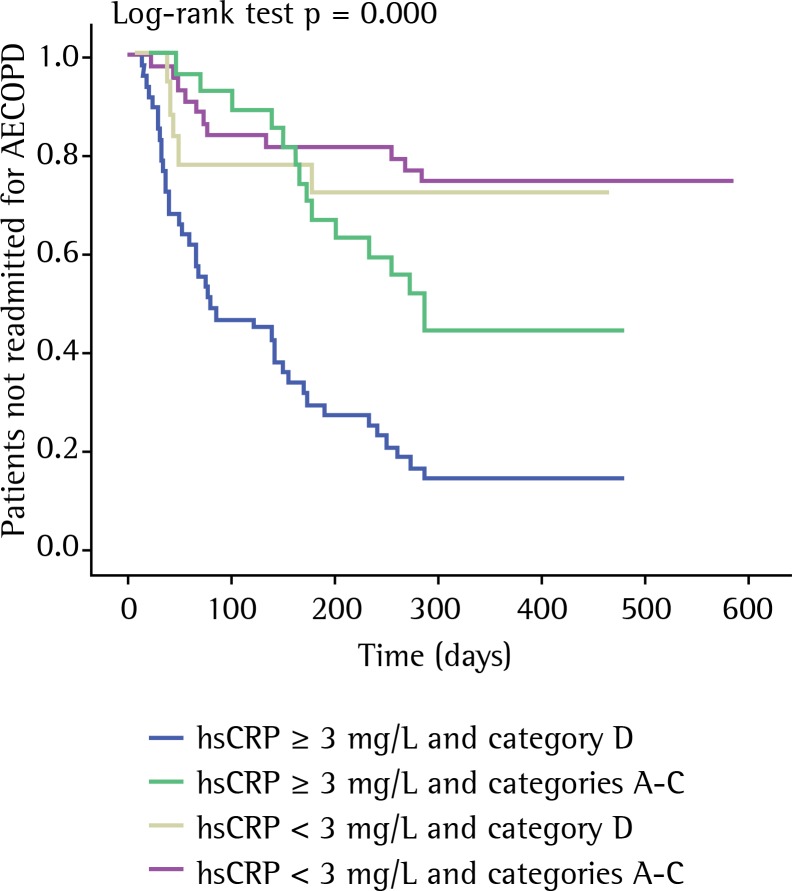
Kaplan-Meier curves showing readmission for acute exacerbation of COPD
(AECOPD) during the 12-month follow-up period after the index AECOPD. The
curves for readmission are presented for the four subgroups of the patient
cohort, categorized on the basis of the patient serum level of high-sensitivity
C-reactive protein (hsCRP) at discharge and the Global Initiative for Chronic
Obstructive Lung Disease (GOLD) risk category. The order of the groups, ranked
from highest to lowest readmission rate (p < 0.001), was as follows: serum
hsCRP = 3 mg/L and GOLD category D; serum hsCRP = 3 mg/L and GOLD categories
A-C; serum hsCRP < 3 mg/L and GOLD category D; and serum hsCRP < 3 mg/L
and GOLD categories A-C.